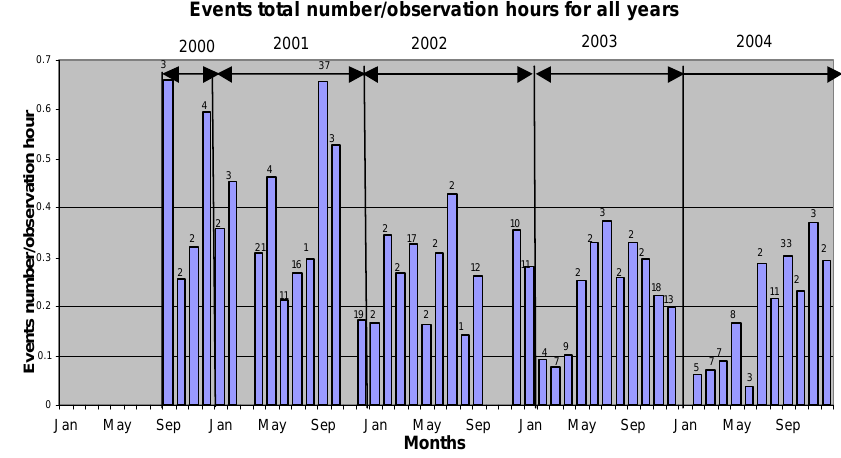
Fig. 2. Frequency of occurrence of waves (ripples and bands) at 1-month intervals. The number above each bar represents the total number Fig. 2 - Frequency of occurrence of waves (ripples and bands) at 1 month intervals. The of events for each number above each bar represents the total number of events for each bin.